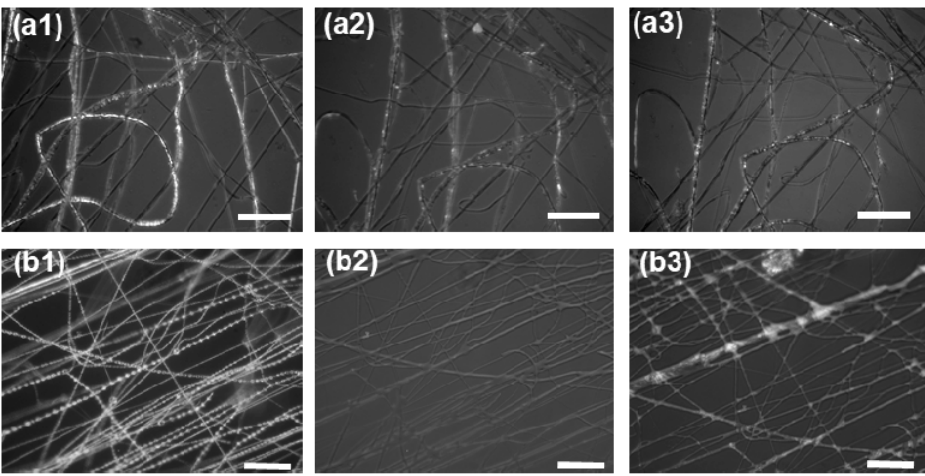
Figure 6. Polarized optical microscopy (POM) images of (a) HA/PEO100 = 1:2 and (b) HA/PEO2 = films at di ff erent stages of heat processing: ( a1 , b1 ) 25 ◦ C; ( a2 , b2 ) 80 ◦ C for 5 min; and ( a3 , b3 ) 25 ◦ C for 1:20 films at different stages of heat processing: ( a1 ) and ( b1 ) 25 °C; ( a2 ) and ( b2 ) 80 °C for 5 min; and 10 min. Scale bar = 5 µ ( a3 ) and ( b3 ) 25 °C for 10 min. Scale bar = 5 μ m.